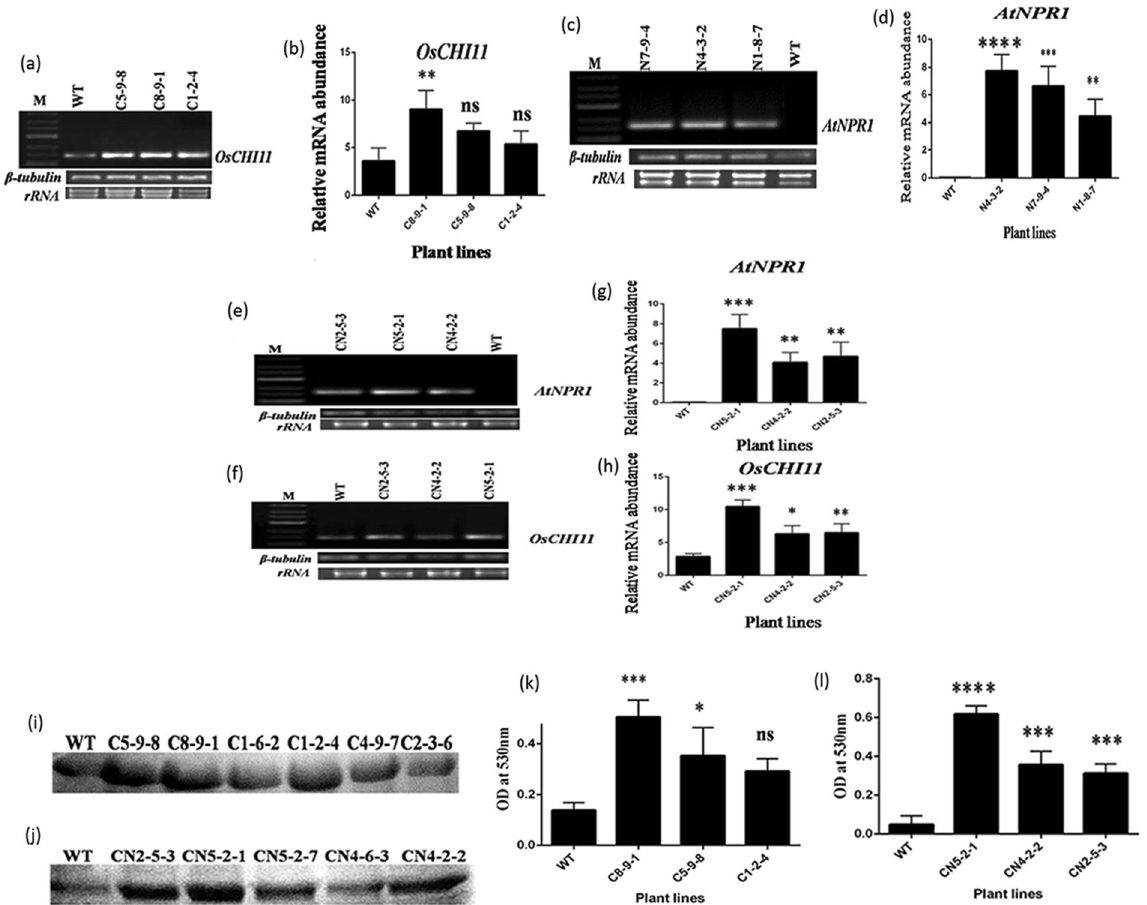
Figure 2. Expression analysis and activity assay of transgenic and wild type plants. ( a ) Semi quantitative RT- PCR analysis of selected T 2 transgenic OsCHI11 overexpressing rice lines using gene specific primers taking β -tubulin as reference control.( b ) Relative quantity of rice OsCHI11 mRNA in leaves of T 2 (C8-9-1, C5-9-8, C1-2-4) overexpressing and WT rice lines as determined by RT-PCR (Real time PCR). ( c ) Semi quantitative RT-PCR analysis of selected T 2 transgenic AtNPR1 rice lines using gene-specific primers taking β -tubulin as internal control. ( d ) Relative quantity of Arabidopsis NPR1 mRNA in leaves of T 2 (N4-3-2, N7-9-4, C1-8-7) overexpressing and WT rice lines as determined by RT-PCR (Real time PCR). ( e ) Semi quantitative RT-PCR analysis of selected T 2 transgenic OsCHI11 - AtNPR1 rice lines using gene-specific ( AtNPR1 ) primer with β -tubulin as internal control. ( f ) Semi quantitative RT-PCR analysis of selected T 2 transgenic OsCHI11 - AtNPR1 rice lines using gene-specific ( OsCHI11 ) primer where β -tubulin acts as internal control. ( g ) Relative abundance of AtNPR1 mRNA in T 2 transgenic (CN5-2-1, CN4-2-2, CN2-5-3) pyramided lines and untransformed WT was determined by real-time PCR using SYBR green.(h) Relative quantity of OsCHI11 mRNA in T 2 transgenic (CN5-2-1, CN4-2-2, CN2-5-3) rice lines and non-transformed WT was determined real -time PCR using SYBR green. Values represent the mean ± SE of three independent experiments. ( i ) In-gel chitinase activity assay of T 2 transgenic and non-transformed wild type (WT) plants. ( j ) In-gel chitinase activity assay of T 2 pyramided transgenic and non-transformed wild type (WT) plants. ( k ) Activity assay (‘In-solution’) of chitinase in T 2 transgenic and WT plants by dinitrosalycylic acid (DNSA) method. Activity was measured by spectrophotometer with an optical density of 530 nm (OD 530 ). ( l ) ‘In-solution’ activity assay of chitinase in T 2 transgenic and WT plants by dinitrosalycylic acid (DNSA) method. Chitinase activity was measured by spectrophotometer with an optical density of 530 nm (OD 530 ). Values are presented as mean ± SE (n =